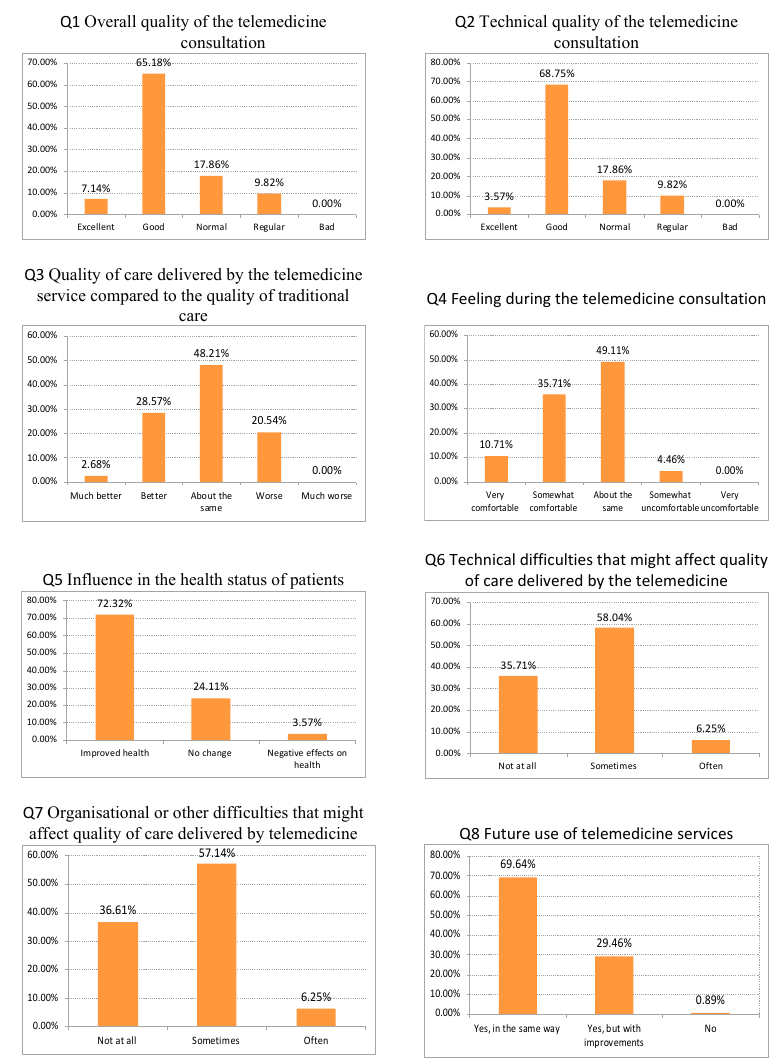
Figure 2. Survey Results.